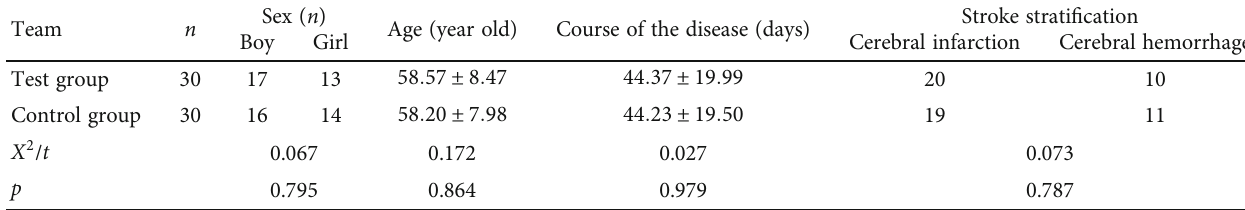
Table 1: Comparison of 2 groups of general information.